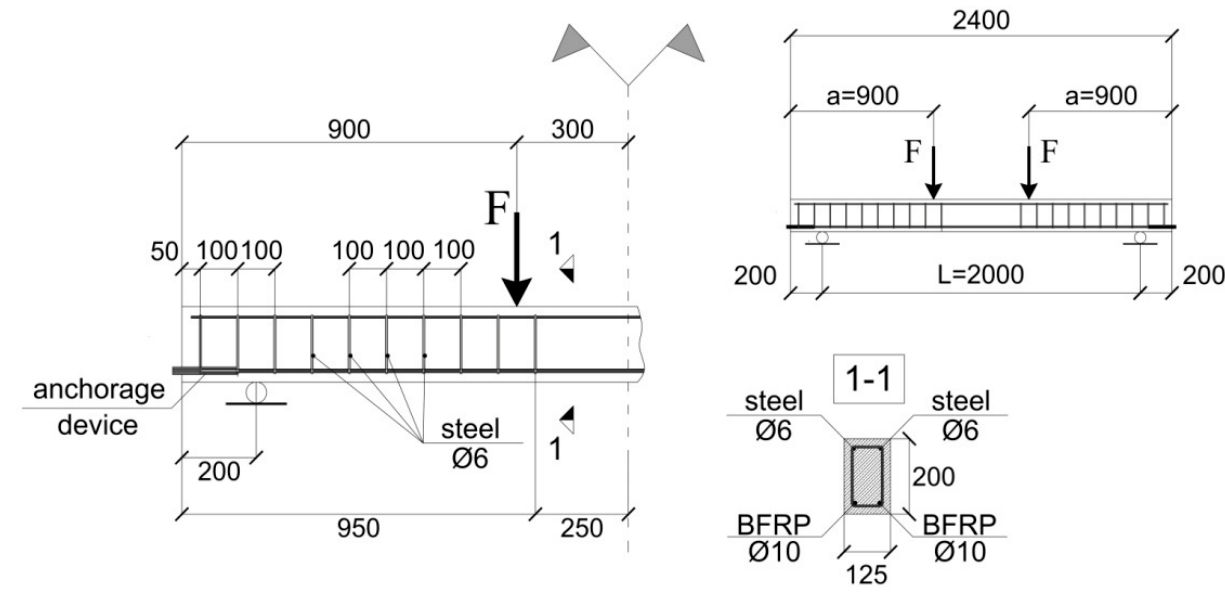
Figure 1. Geometry of the specimen and reinforcement arrangement [21].